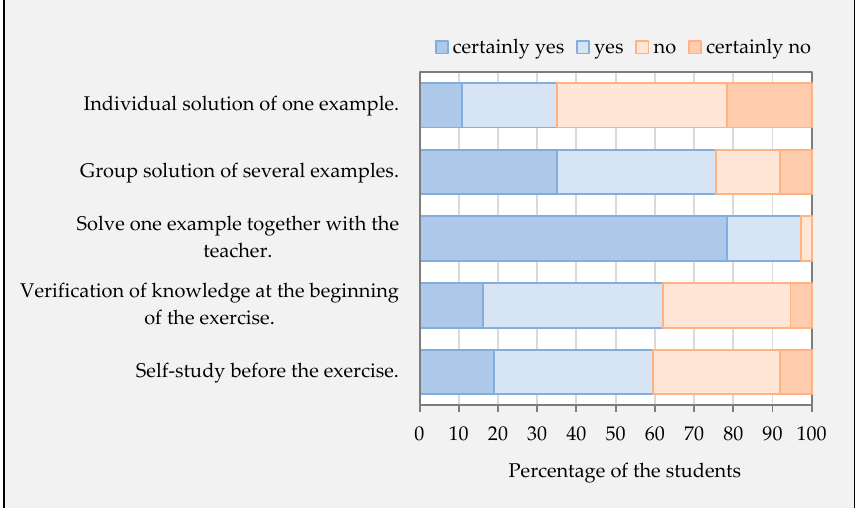
Figure 16. Students’ suggestions for exercise redesign.